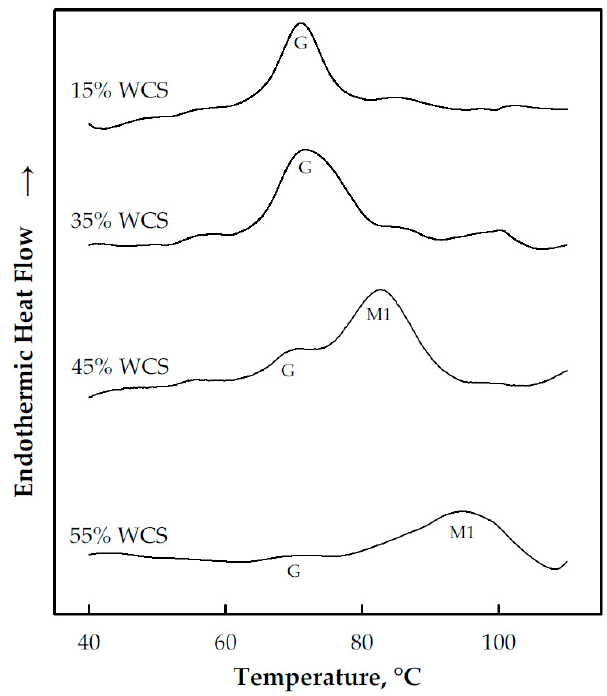
Figure 2. DSC curves of waxy corn starch (WCS) at different levels of water content. The numbers indicate starch content in a wet basis. G, M1 and M2 are endotherms.